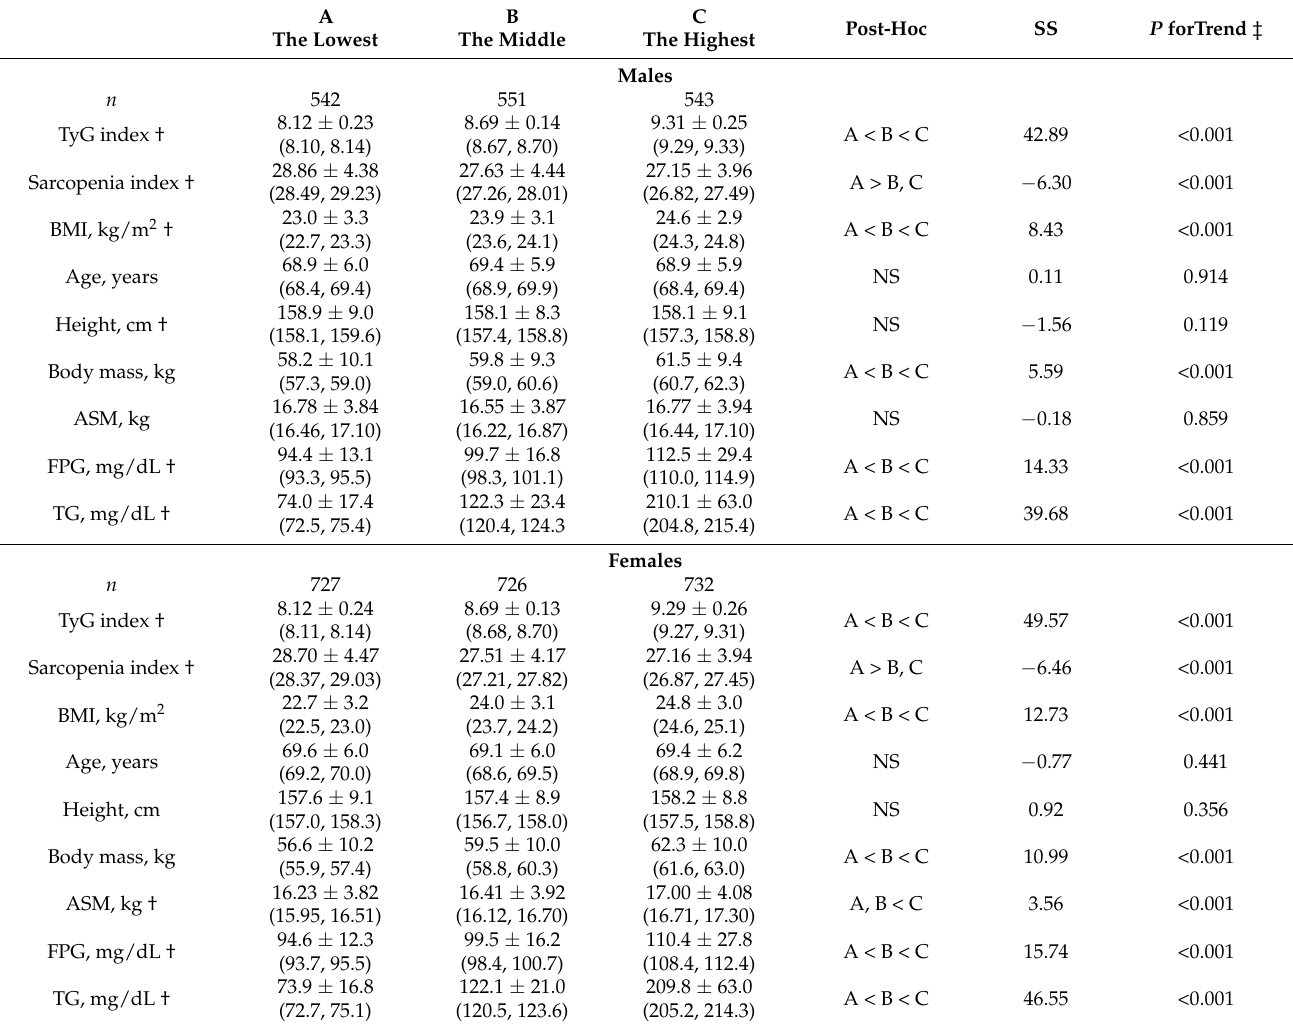
Table 2. Sex-specific differences and trends of participants by TyG index